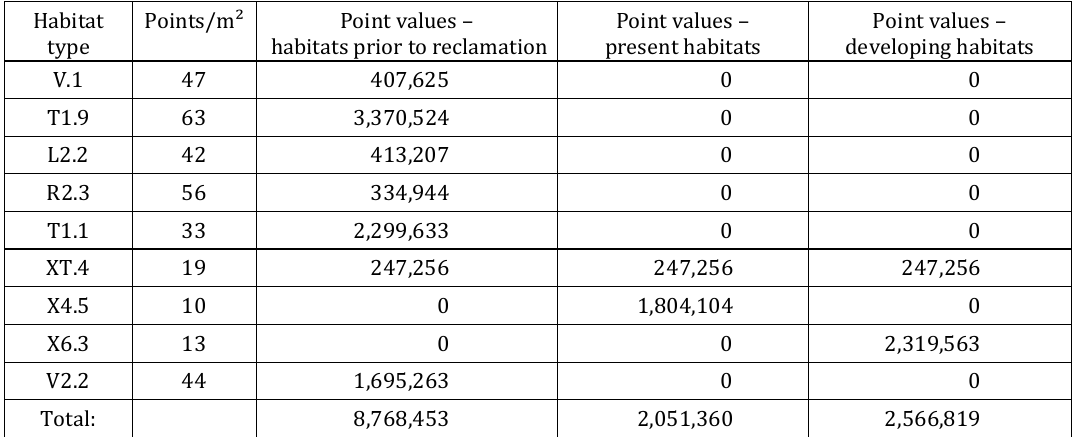
Table 4. Point values for particular habitats